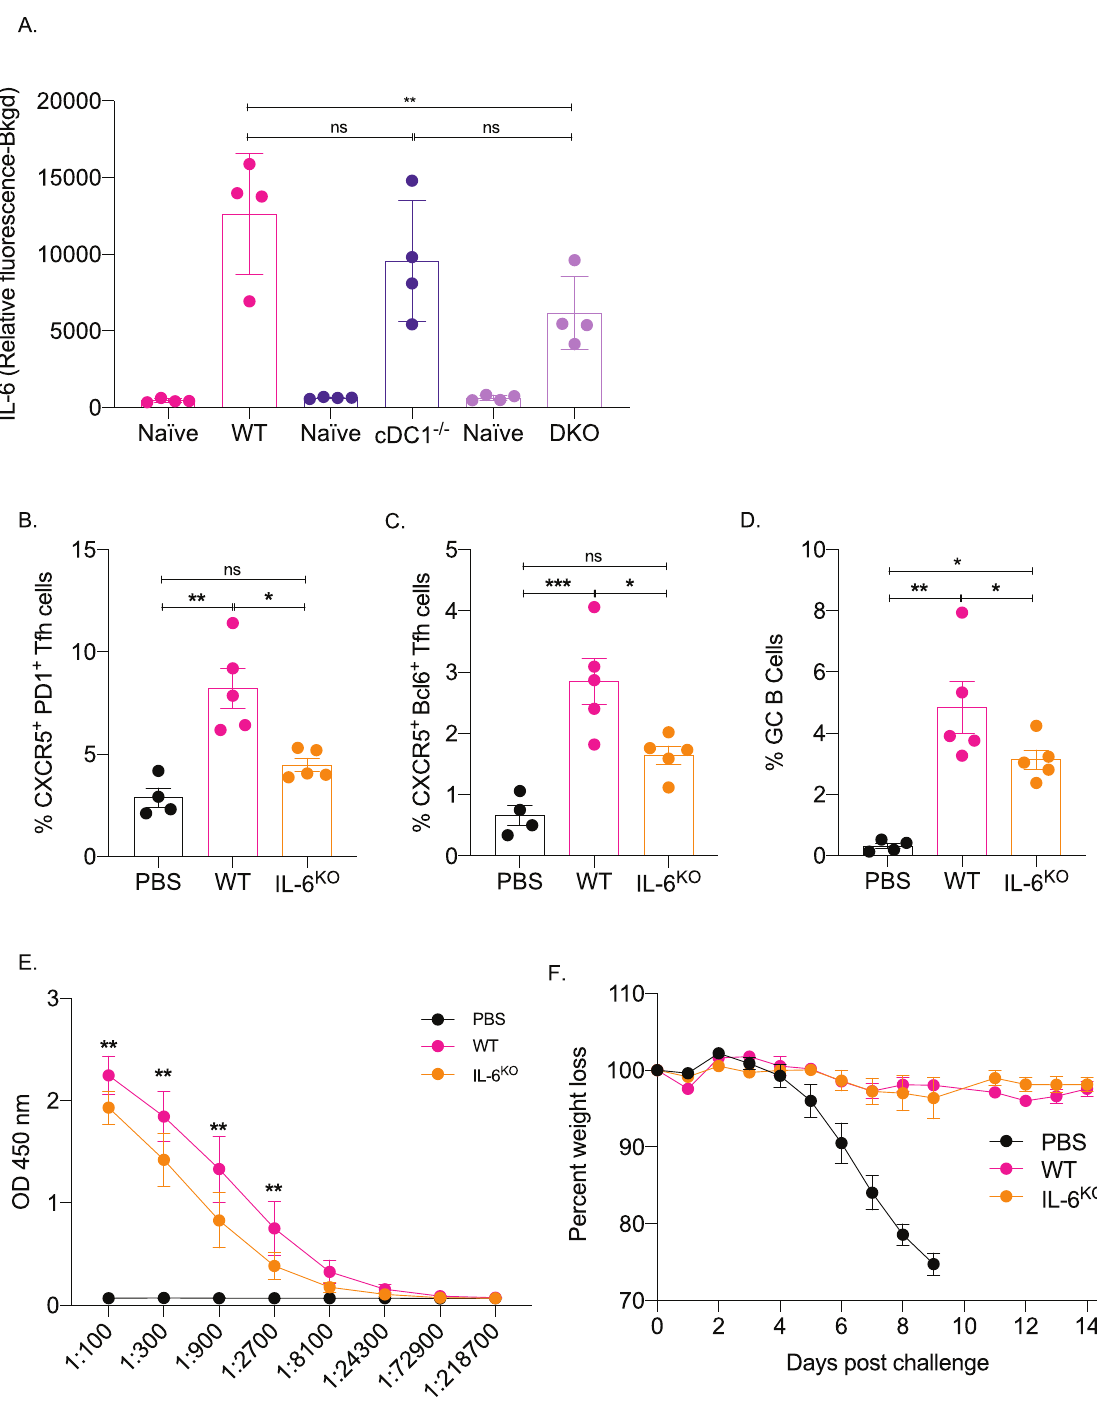
Fig 3. IL-6 is required for the induction of adaptive immune responses by the mRNA-LNP platform. A . The indicated mice were injected intradermally with 2.5 μ g of non-coding polycytosine mRNA-LNP and the skin samples tested for IL-6 with Luminex 24 hours later. B . and C . WT and IL-6 knockout mice were intradermally injected with 10 μ g of mRNA-LNP coding for PR8 HA or PBS. Seven days later the Tfh cells were characterized in skin draining lymph nodes using flow cytometry. D . as in B and C , except the lymph nodes were harvested 14 days post injection and the GC B cell responses determined by flow cytometer. Each dot represents a separate animal. E . Serum samples at day 14 post injection were assessed for anti-HA IgG levels using ELISA. F . The indicated animals were immunized with 10 μ g of mRNA-LNP coding for PR8 HA or injected with PBS. Fourteen days later the animals were challenged with 5,000 TCDI PR8 influenza virus and the weight drop monitored as presented. Data from two independent experiments pooled, 5–9 mice/group.